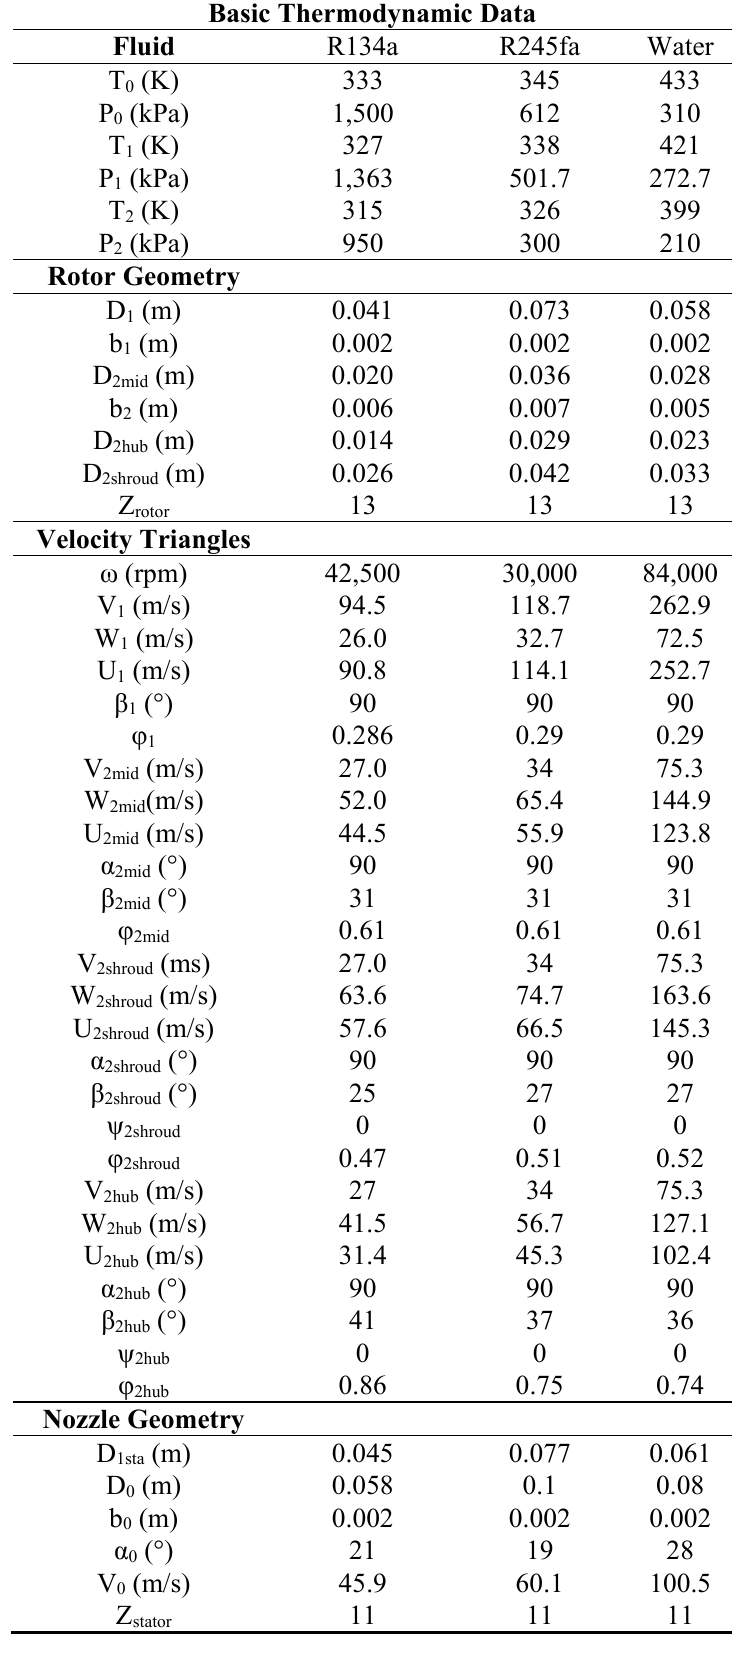
Table 4. Expander design